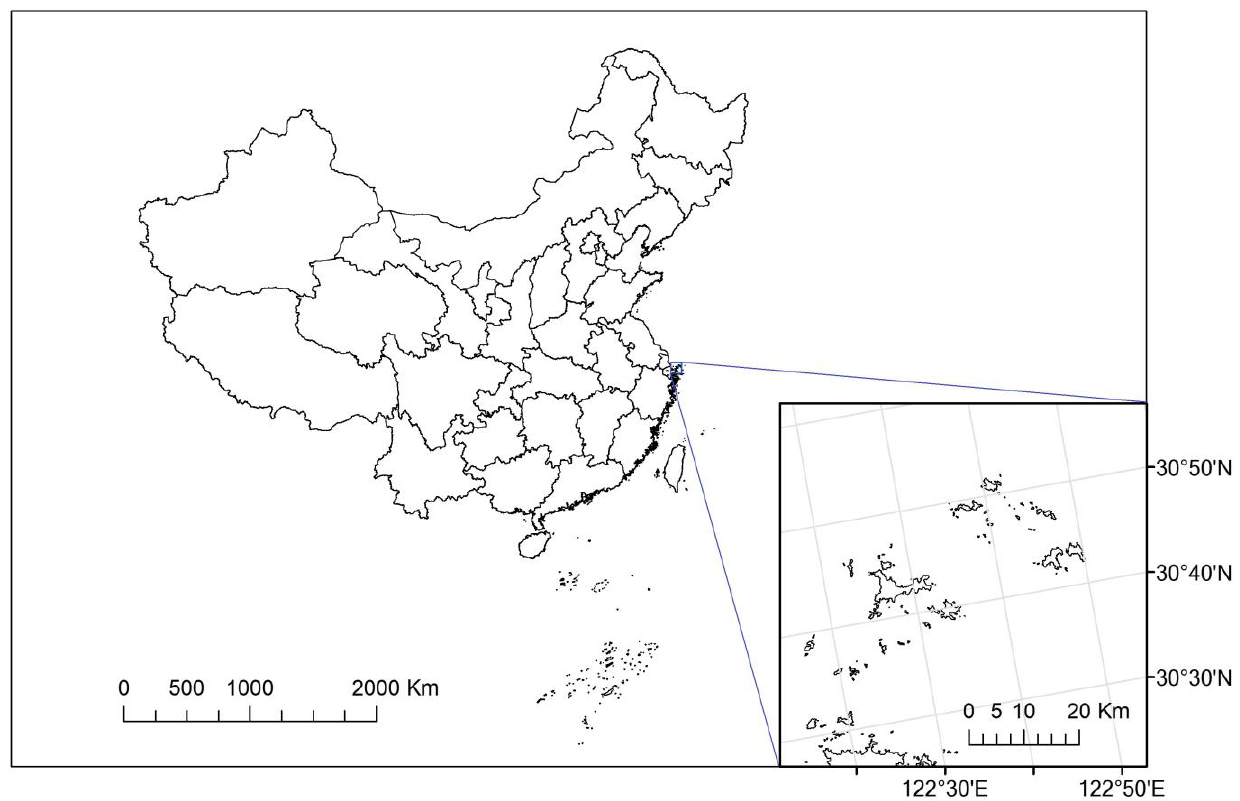
Figure 1. Geographic location of Shengsi County, China.